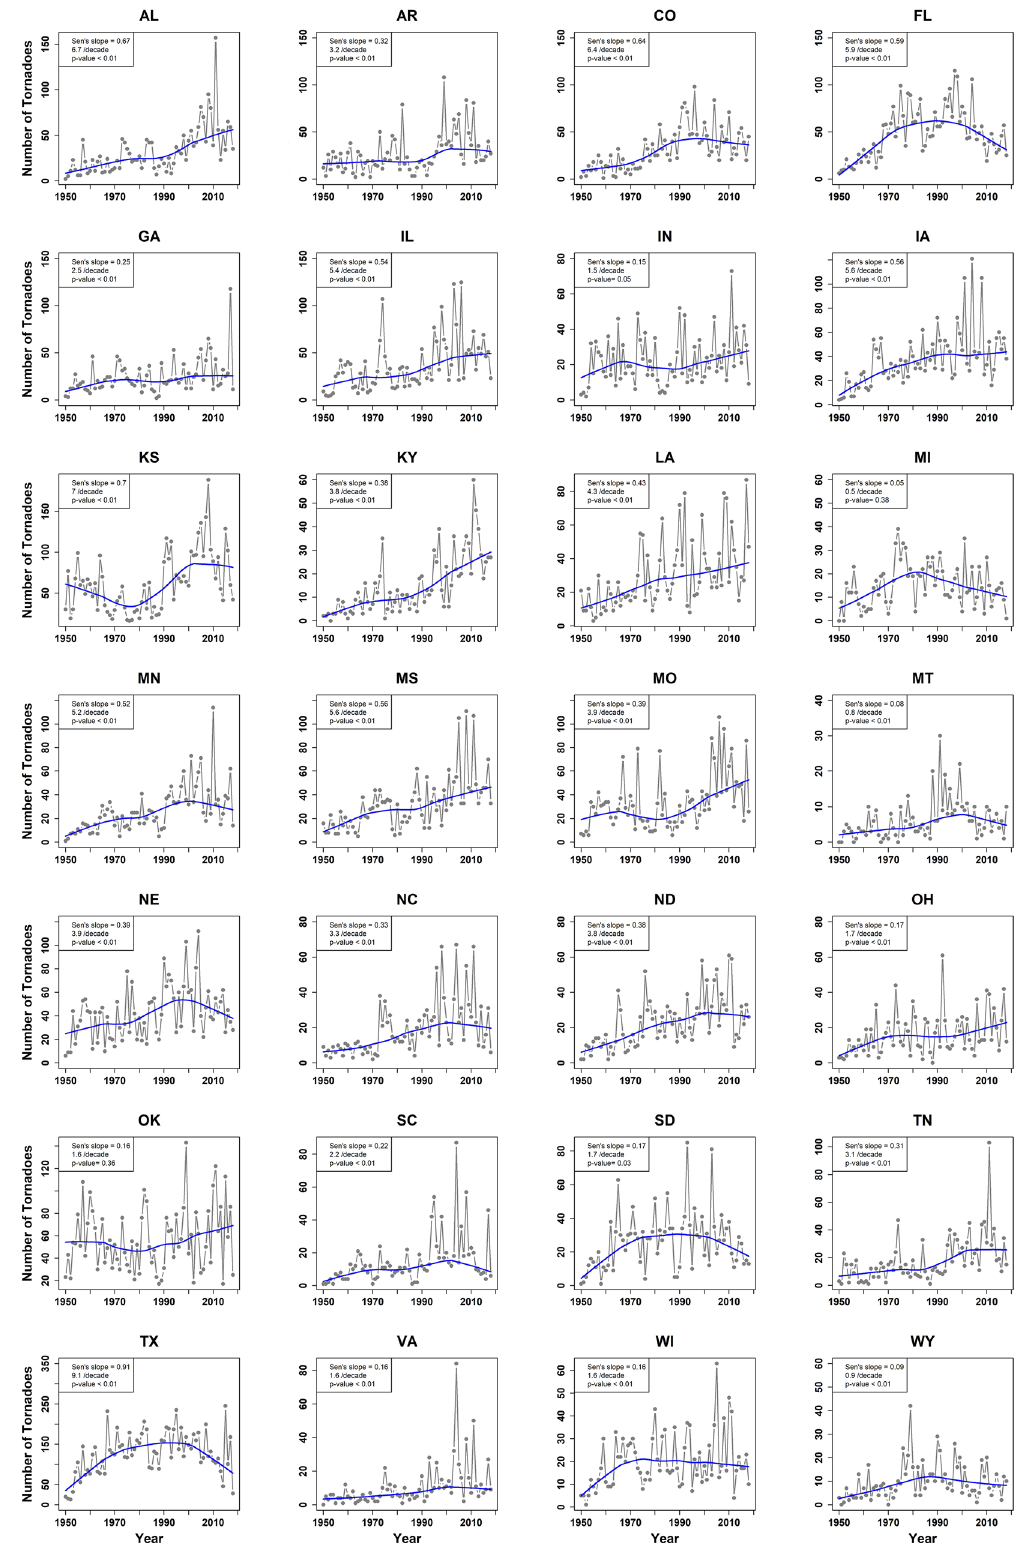
Figure 1. Annual number of tornado incidence in 28 major tornado-impacted states in the U.S. during 1950–2018. The blue line is locally-weighted polynomial fit 20 using a smoothing span of 0.5. For each state, Mann–Kendall trend test is performed and the p-value of the test along with Sen’s slope or the rate of change is